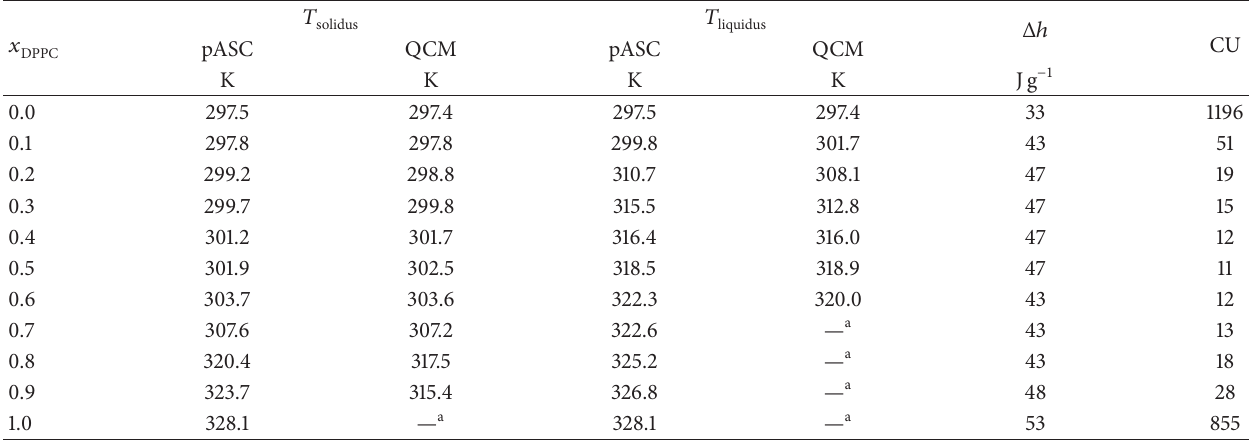
Table 3: Onset and completion temperatures, total heats, and cooperativity units for DMPC + DSPC mixtures obtained from pASC measurements, as well as onset and completion temperatures obtained from QCM-D